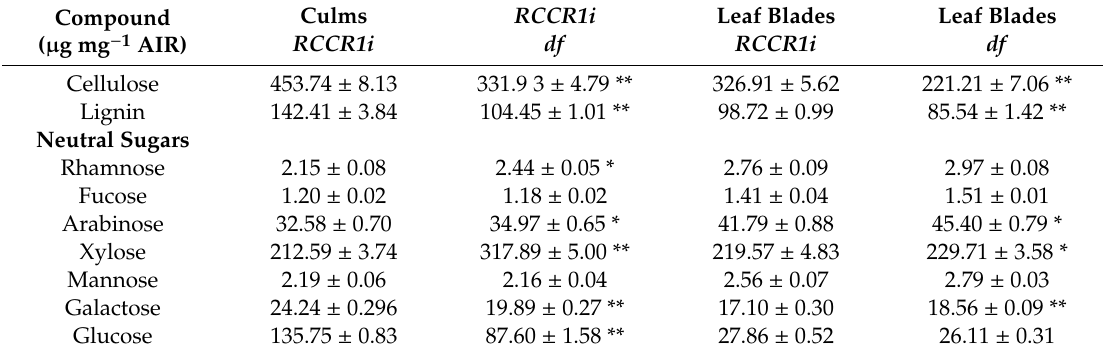
Table 1. Measurement of the cell wall composition in df and RCCR1i plants.